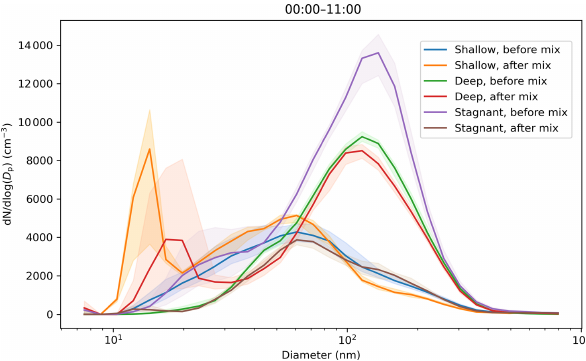
Figure 12. Impact of convective mixing on the aerosol particle size distributions measured at the surface for 3 case study days. Hourly median values are used. Aerosol particle size distributions are averaged from midnight to start of convective mixing and from start of convective mixing to 11:00LT. Convective mixing was as- sumed to start at 09:00LT for the shallow-boundary-layer case study; 07:00LT for the deep boundary layer with transport aloft; and around 08:00LT for the deep boundary layer with a stagnant residual layer aloft, i.e. no significant transport (denoted stagnant in the plot). The shaded areas indicate the median ± the interquartile range of the